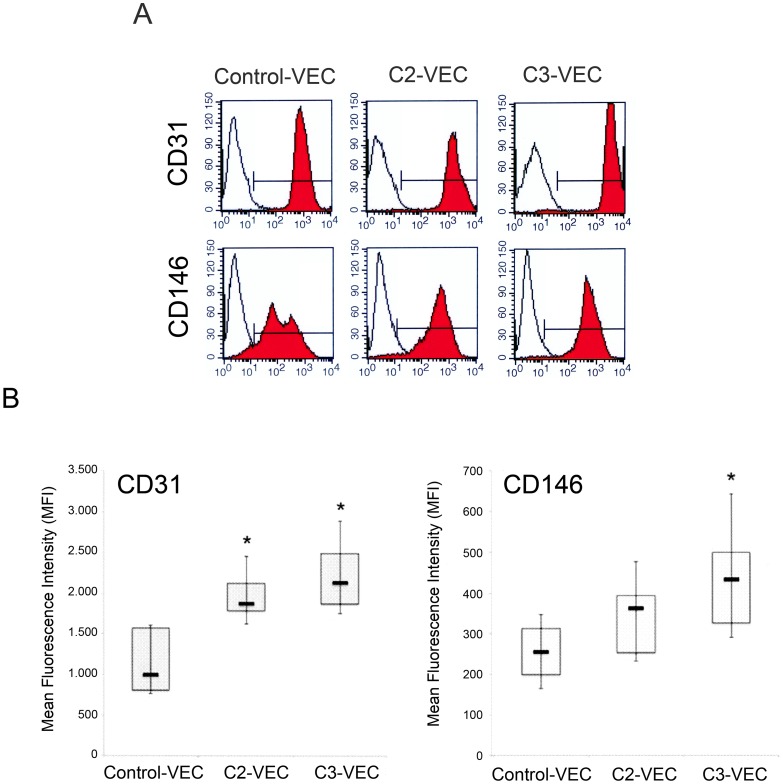
Differential phenotype between control and pathological VEC.Surface expression of CD31 and CD146 was evaluated by flow cytometry in either pathological and control-VEC. In A, colored histograms represent cells stained with monoclonal antibodies specific for the indicated antigens and white histograms represent background fluorescence obtained by staining the same cells with isotype-matched control antibodies. Representative panels for control, C2- and C3-VEC are shown. In B, the expression levels of the indicated antigens were determined for all VEC samples (8 C2-VEC, 13 C3-VEC and 5 control-VEC) by flow cytometry analysis and expressed as mean fluorescence intensity (MFI). Horizontal bars are median, upper and lower edges of box are 75th and 25th percentiles, lines extending from box are 10th and 90th percentiles. *P<0.05 compared to control VEC.